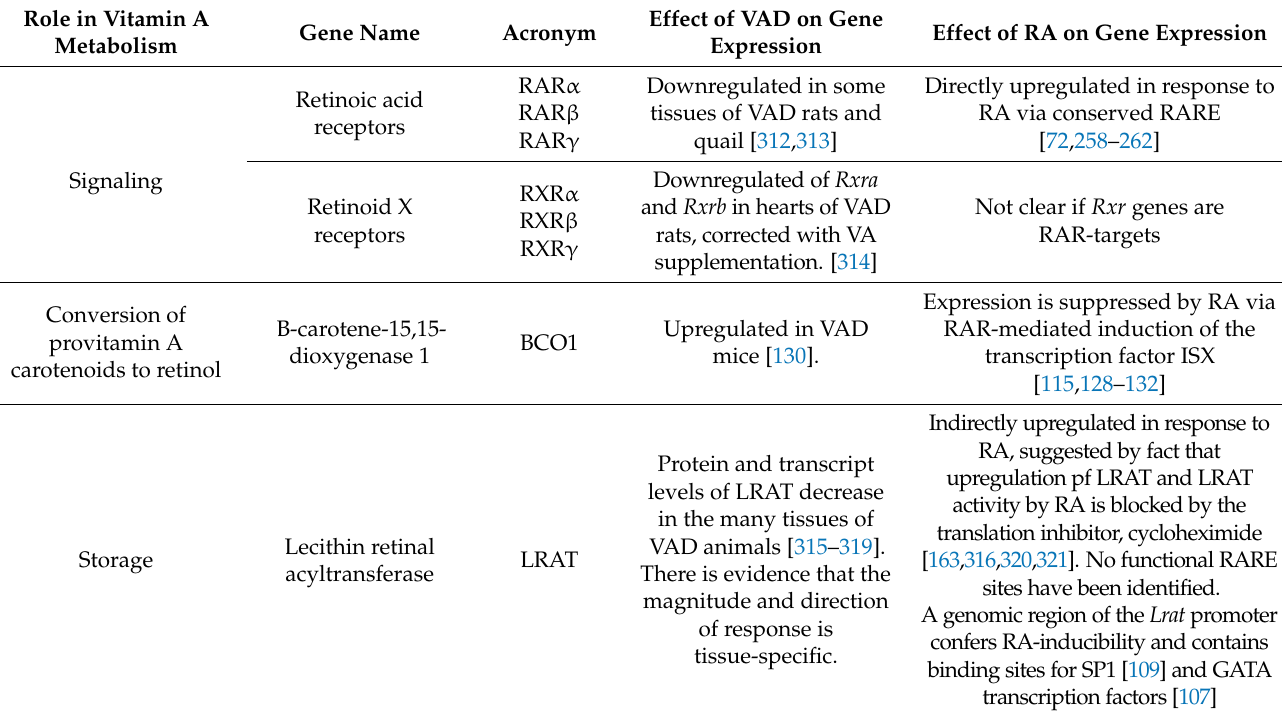
Table 1. Regulation of retinoid genes in response to RA Treatment and VAD Diet. Only retinoid genes currently known to respond to RA are